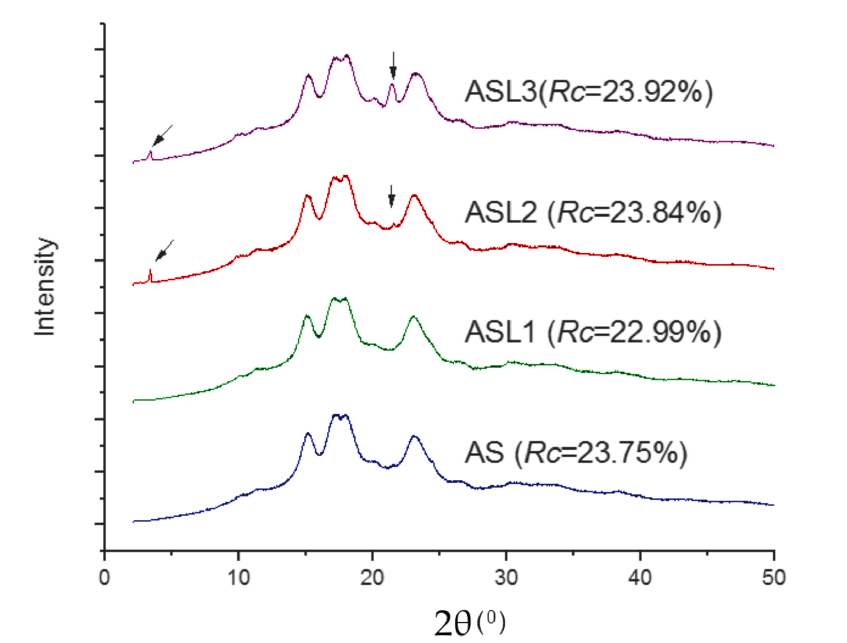
Figure 4. Diffraction patterns and relative crystallinity of native (AS) and modified amaranth starch derivatives (ASL1, ASL2 and